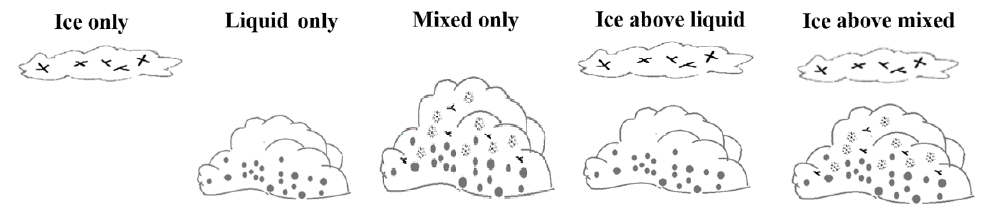
Figure 1. Schematic of cloud classification based on the 2B-CLDCLASS-LIDAR product.